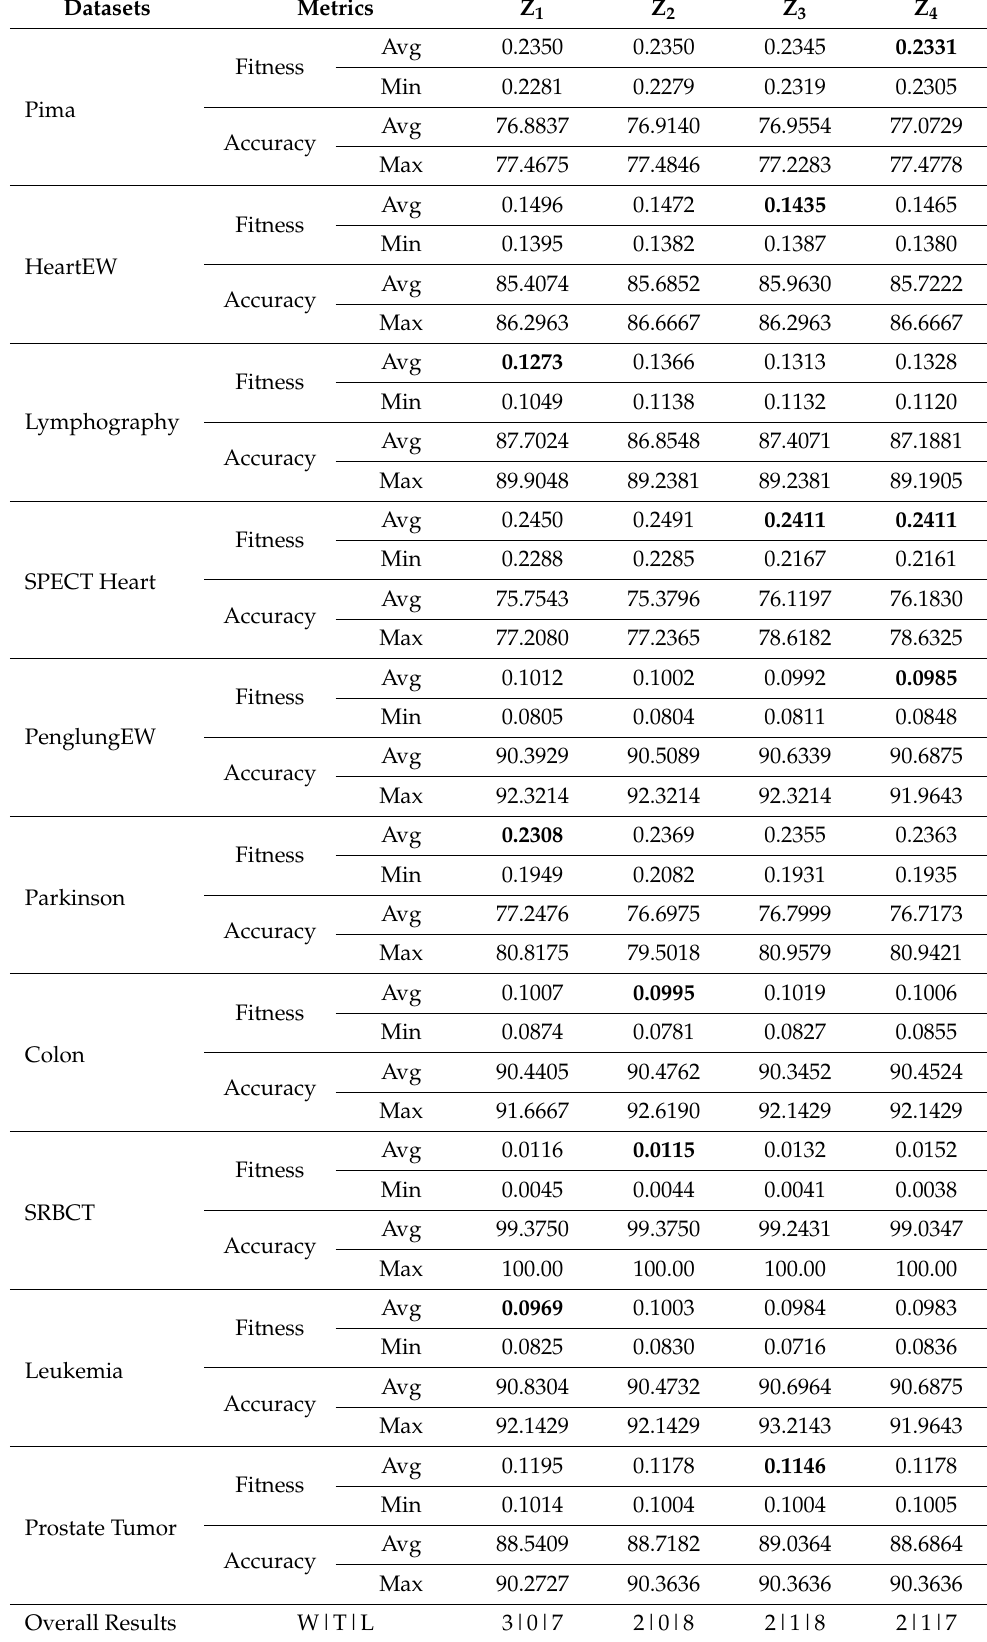
Table A4. The comparison results between different versions of